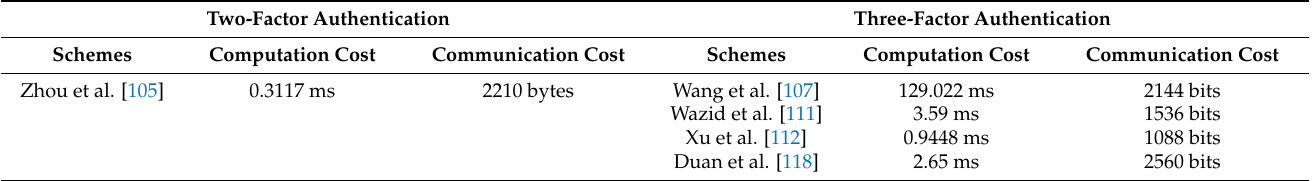
Table 19. Performance comparison of smart-card-based (two vs three vs multi-factor) schemes.